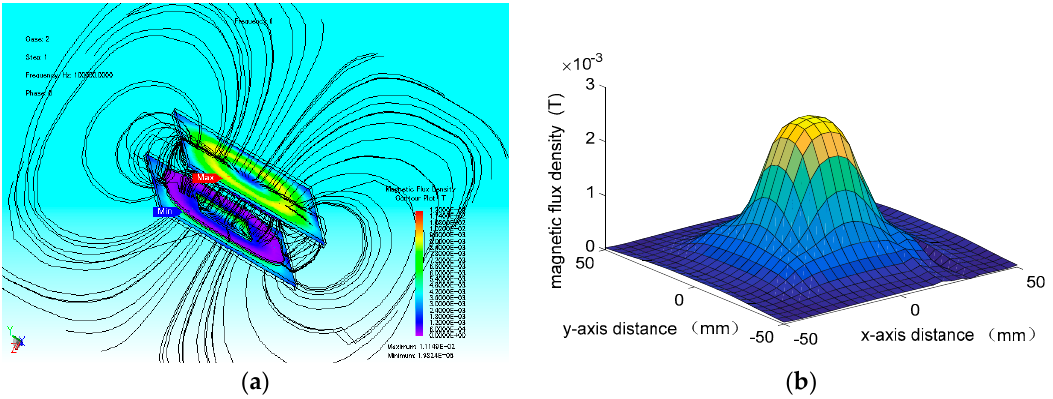
Figure 6. Magnetic field distribution: ( a ) magnetic flux line distribution; ( b ) magnetic flux density distribution at the plane between two parallel coils.